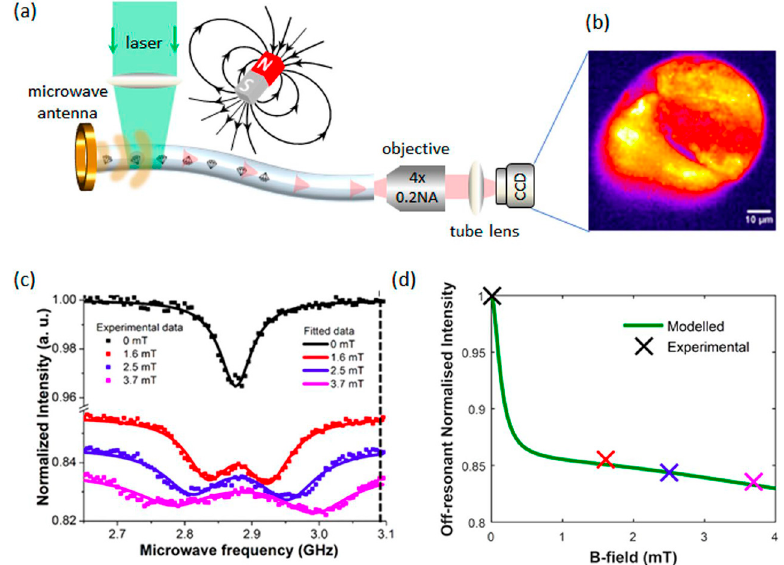
Figure 7. Magnetically sensitive ND-doped tellurite glass fiber. ( a ) Schematic diagram of the optically detected magnetic resonance using ND-doped tellurite glass fiber. ( b ) Image of the NV emission from the fiber end face captured using an sCMOS camera. ( c ) Output spectra of the sensor with varying magnetic field strength. ( d ) Theoretical and experimental results for the off-resonant fluorescence intensity versus magnetic field [182] . Copyright 2018, Springer Nature.